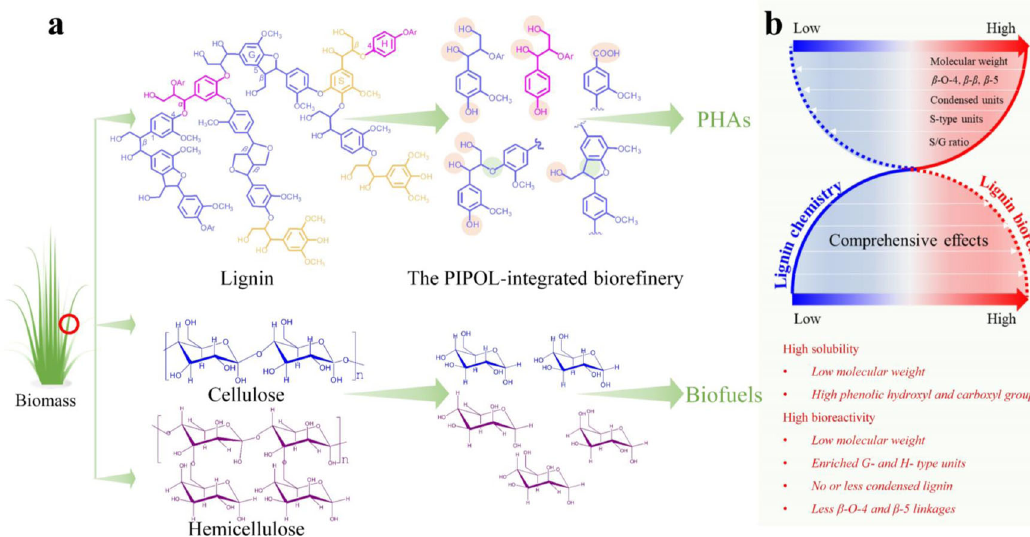
Fig. 6 The proposed mechanisms for the improved biological lignin valorization in biore fi nery. a PIPOL-integrated biore fi nery deconstructed lignin – carbohydrate complex of lignocellulosic biomass to enhance lignin solubility and carbohydrate accessibility; b The potential relationships between lignin chemistry and bioreactivity for microbial conversion. PIPOL represents plug-in processes of lignin. PHAs represent polyhydroxyalkanoates; S-, G-, and H-type represents syringyl, guaiacyl, and p -coumaryl unit of lignin,